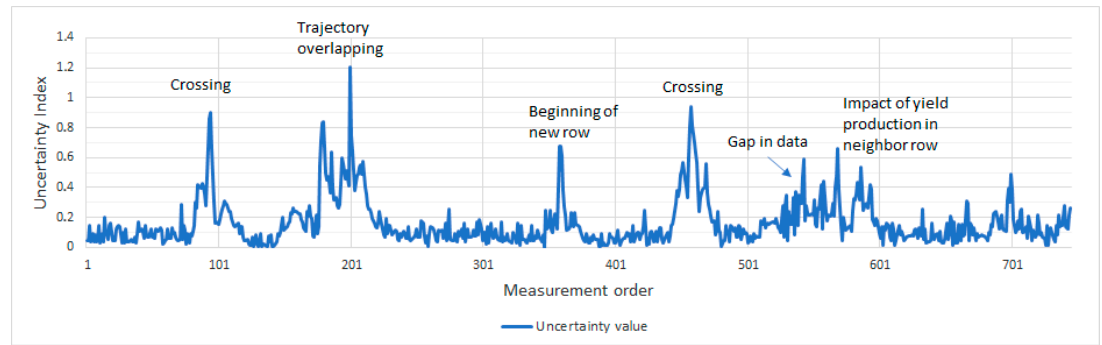
Figure 4. The mean and the range of yield values in crossings of problematic parts of farm machinery trajectory: a demonstration of point measurements for proof-of-concept uncertainty definition.